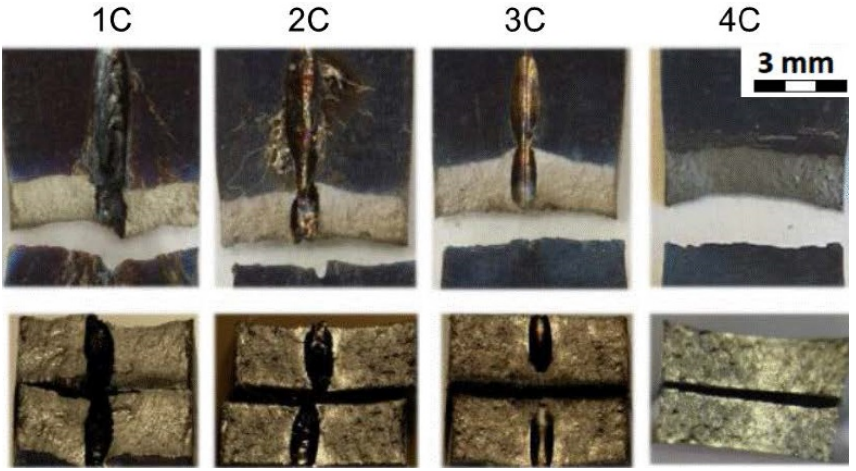
Figure 17. Fracture areas and fracture surfaces of individual sample groups—material thickness 1.6 mm; tests at elevated temperature.